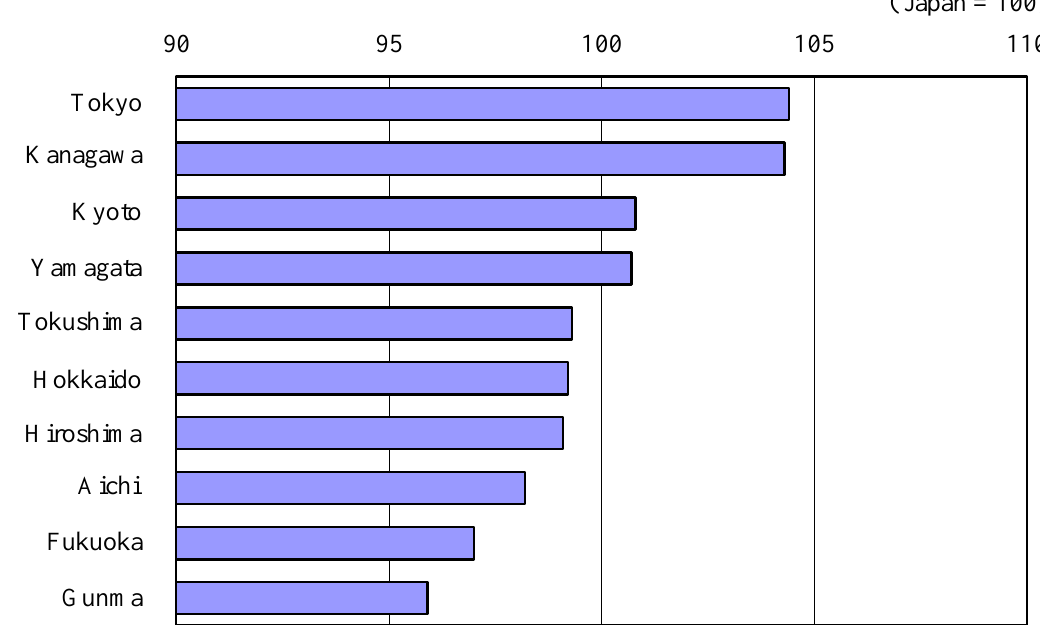
Regional Difference Index of Consumer Prices by Selected Prefectures